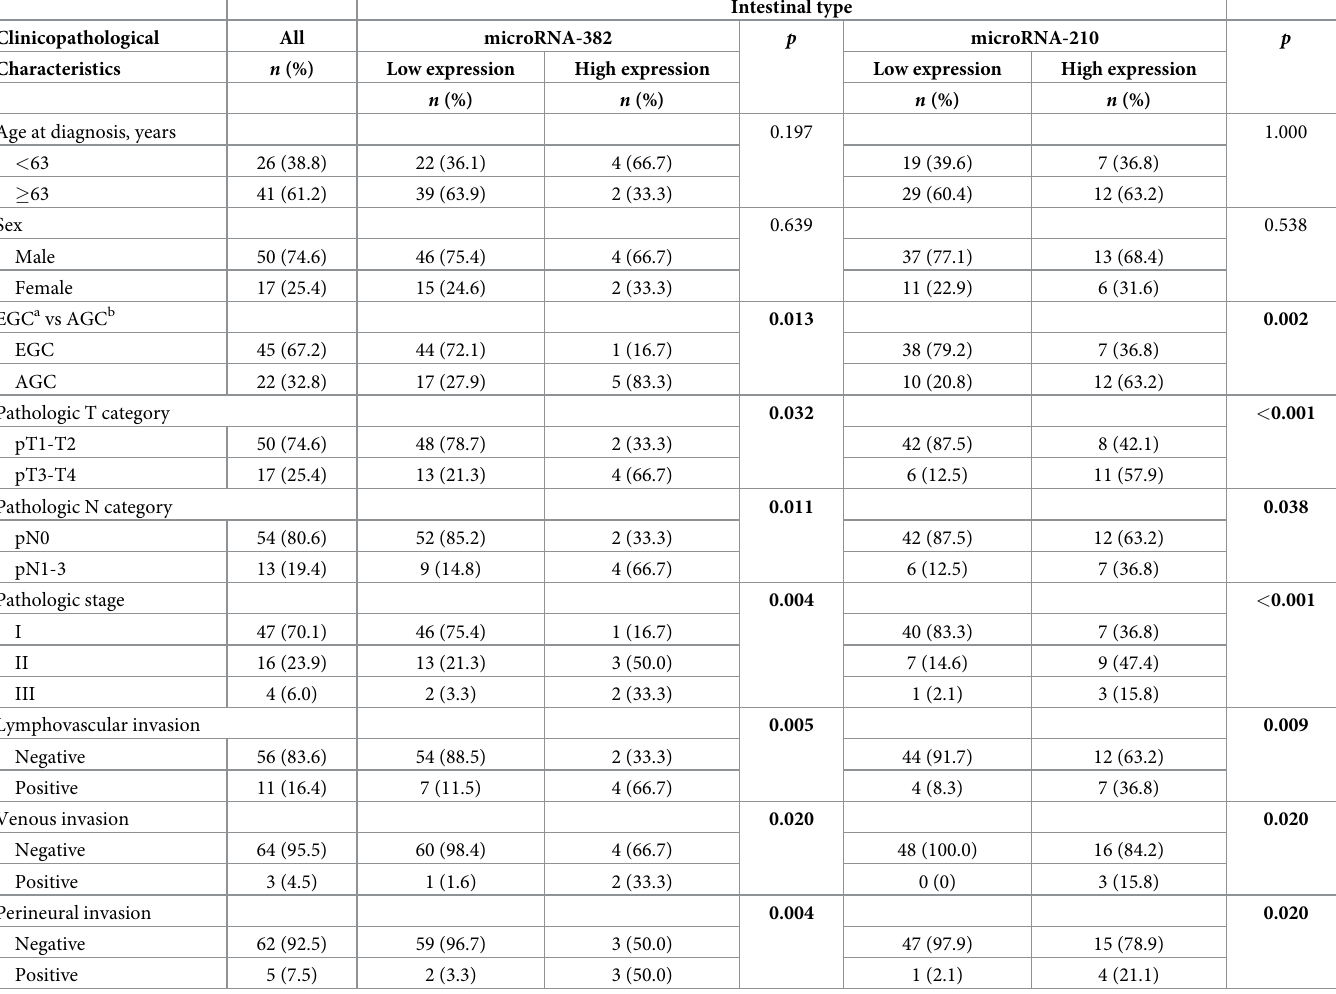
Table 3. Relationship between clinicopathologic characteristics of tumor and expression levels of miR-382 and miR-210 in gastric adenocarcinoma with intestinal type of Lauren